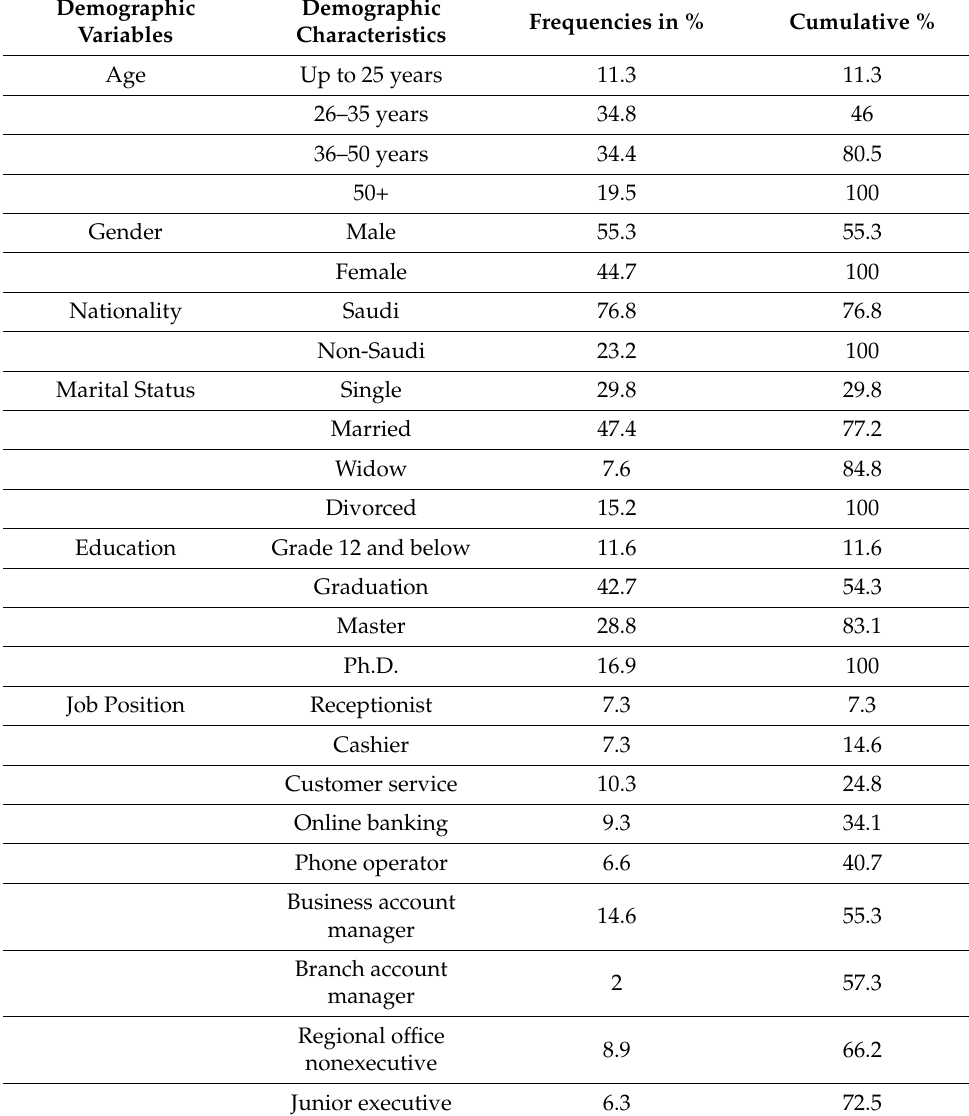
Table 1. Demographic characteristics of the